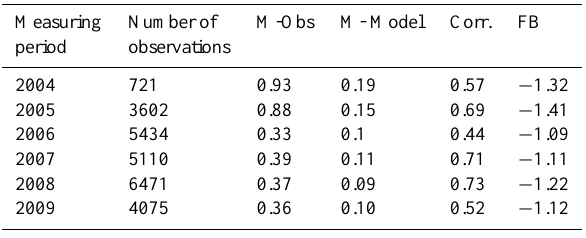
Table 2. Comparison of the mean (M) monoterpenes mixing ra- tios (ppbV) between observed and calculated data by DEHM, us- ing MEGAN biogenic model, for the measuring period 2004–2009. The evaluations for the 6years individually at Thompson Farm in Durham, New Hampshire (US) (Haase et al., 2011) are performed using statistics of the correlation coefficient (Corr.) and the frac- tional bias (FB).